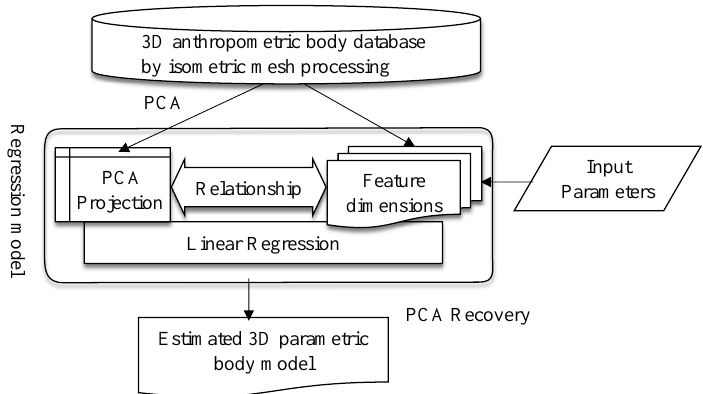
Figure 5. Procedure of parametric model construction.